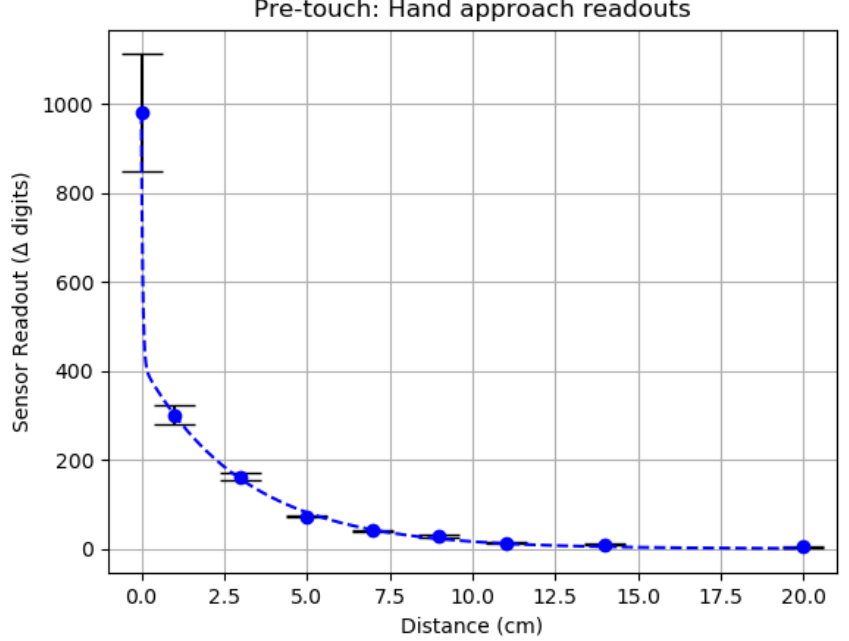
Figure 17. Capacitive proximity sensing: “pre-touch” experiment